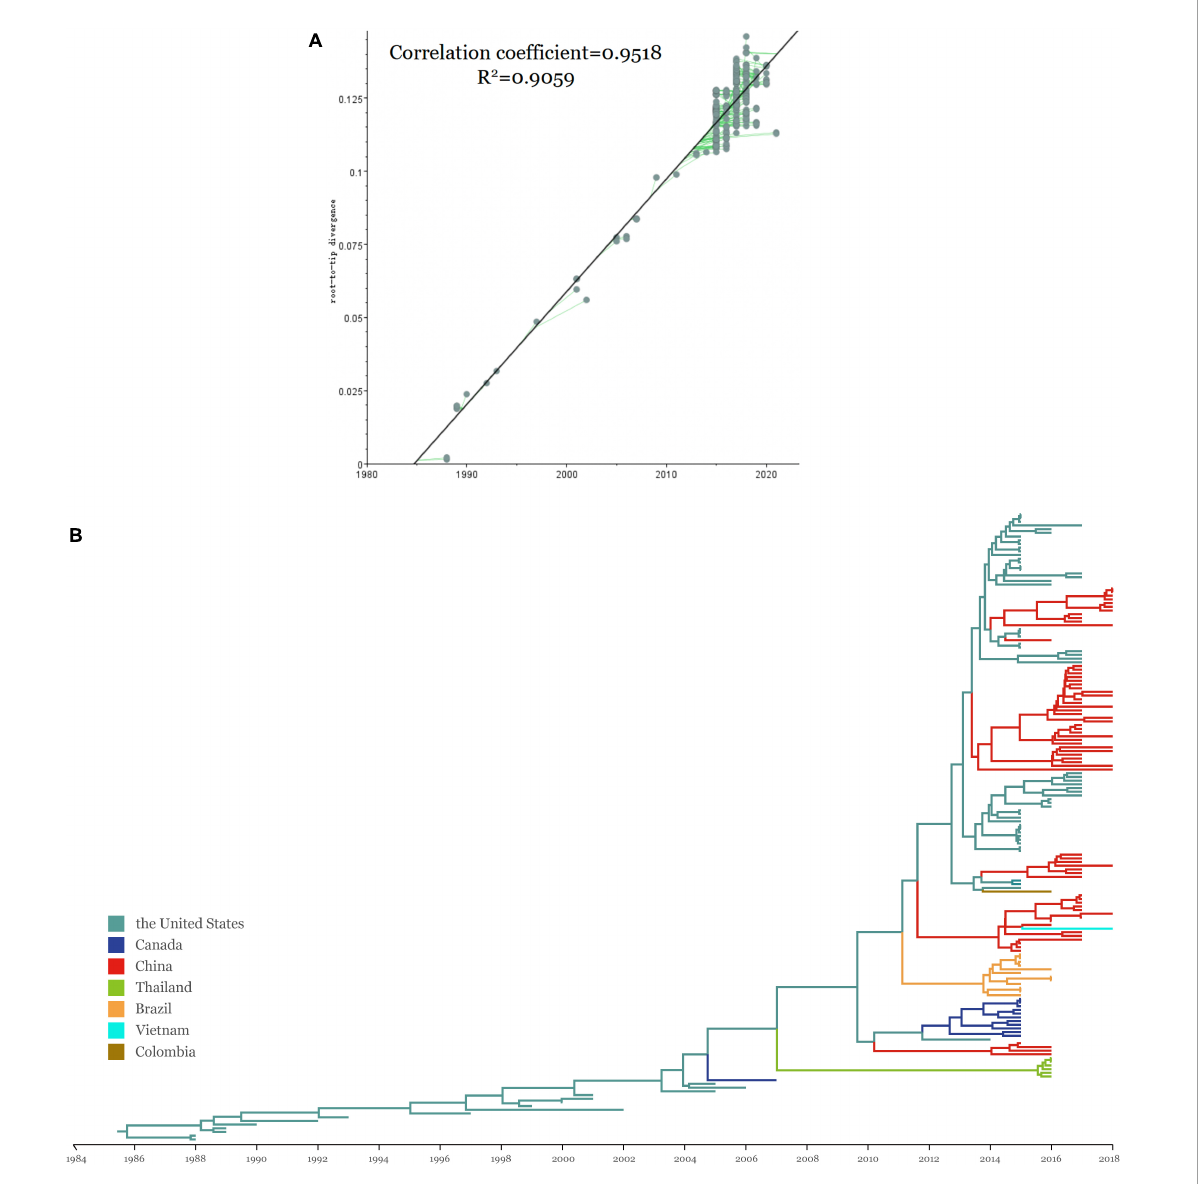
FIGURE2 (A) Regression of the RTT genetic distance against the sampling time for evaluation of the molecular clock models using TempEst v1.5.3. Parameters including correlation coefficient and R2 are shown beside the linear regression. (B) The MCC tree of SVA strains using the ORF gene with BEAST v1.10.4 and FigTree v1.4.4. Colors represent different sampling locations, namely the United States (teal), China (red), Canada (blue), Colombia (tan) and Brazil (orange), Thailand (green), and Vietnam